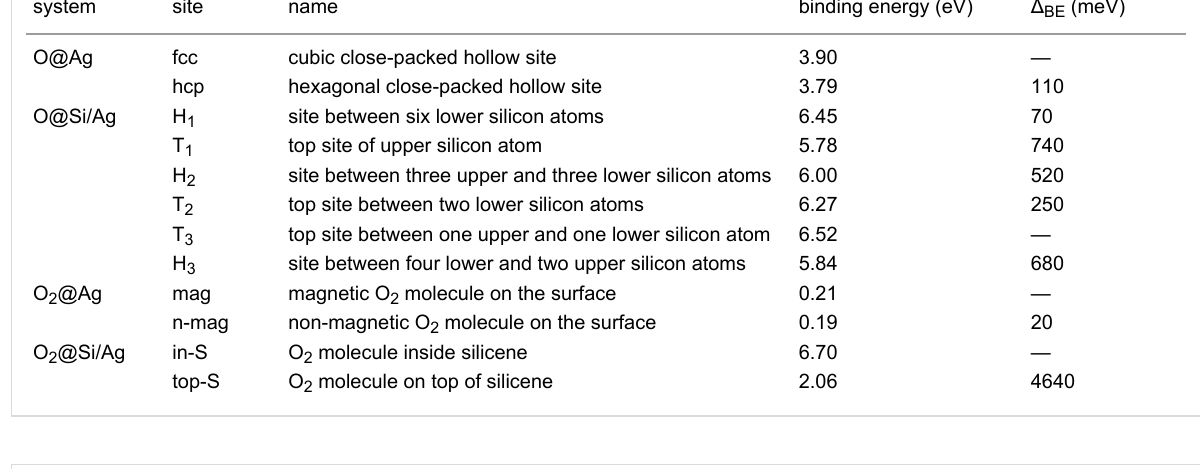
Table 1: Binding energies of O/O 2 on Ag(111) and silicene-coated Ag(111). Ag refers to the Ag(111) surface, Si/Ag refers to silicene-coated Ag. system